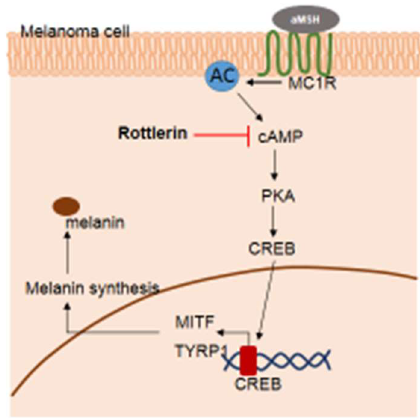
Figure 6. Potential pathway by which rottlerin regulates melanogenesis in melanoma cells.